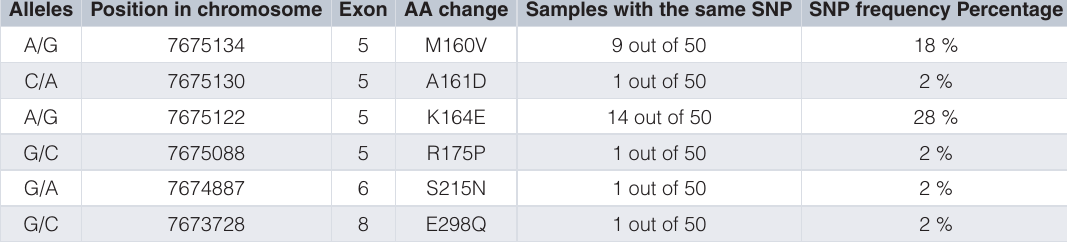
Table 9. SNPs information and frequency among different samples.